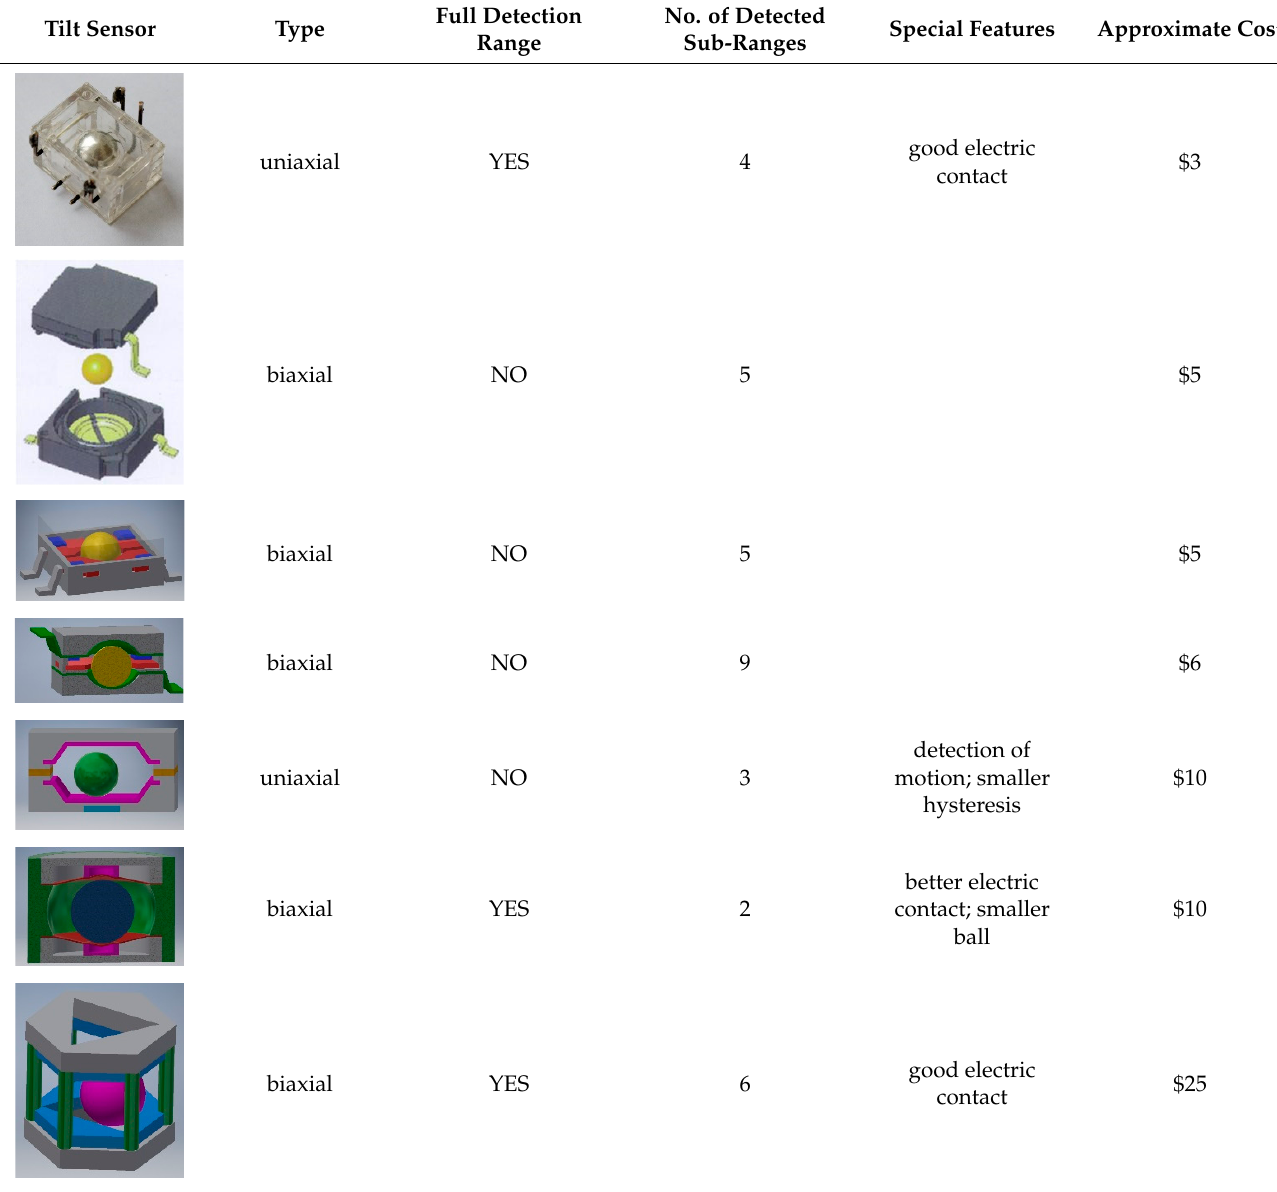
Table 4. Distinctive features of the presented tilt sensors.